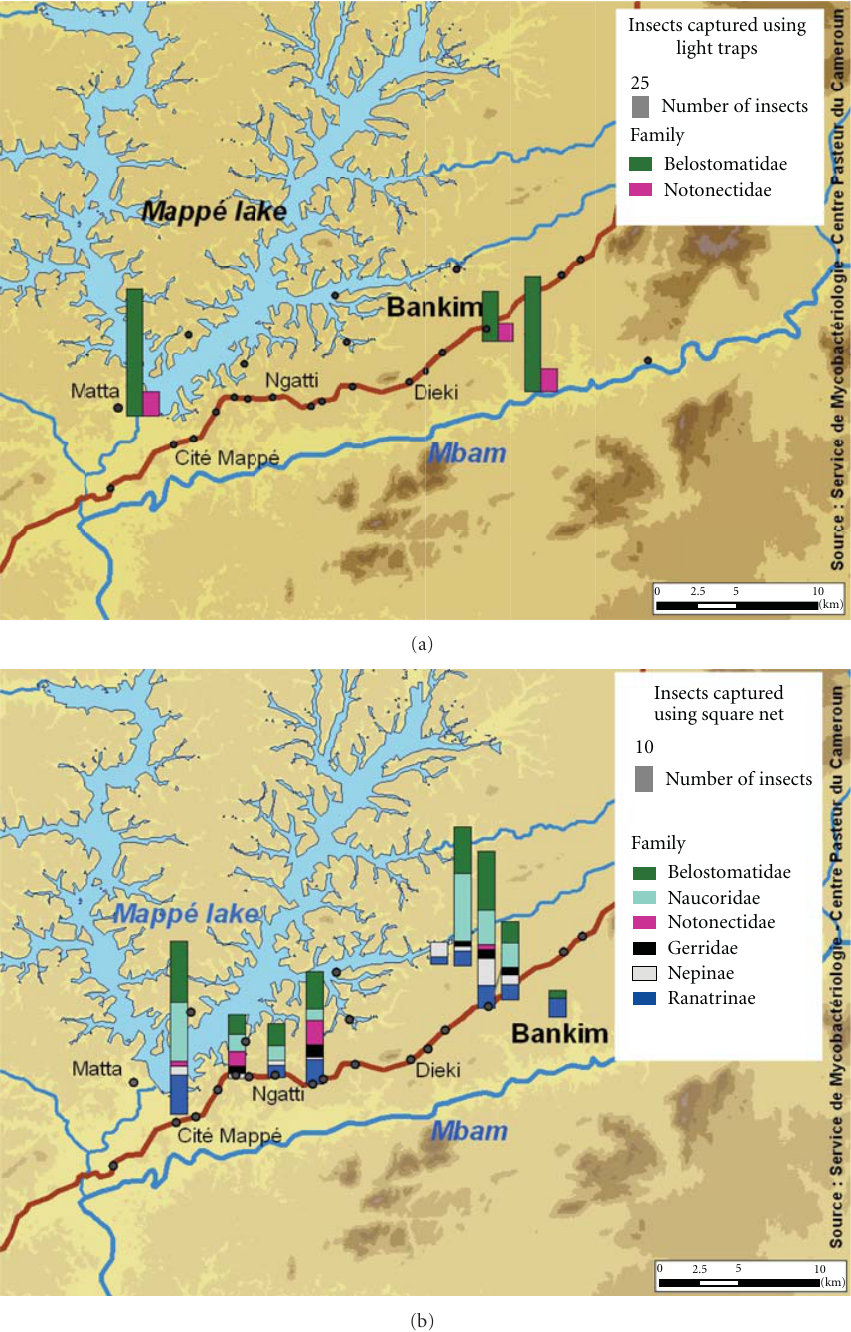
Figure 3: (a) Distribution of Hemiptera captured in the night by light traps; (b) distribution of Hemiptera collected directly in the water bodies by